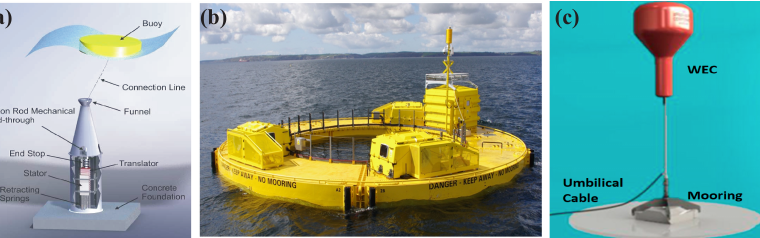
Figure 4. The Seabased device [58], the LifeSaver device [78] and the CorPower device [79] are shown as typical examples of floating one-body PAs in ( a – c ),